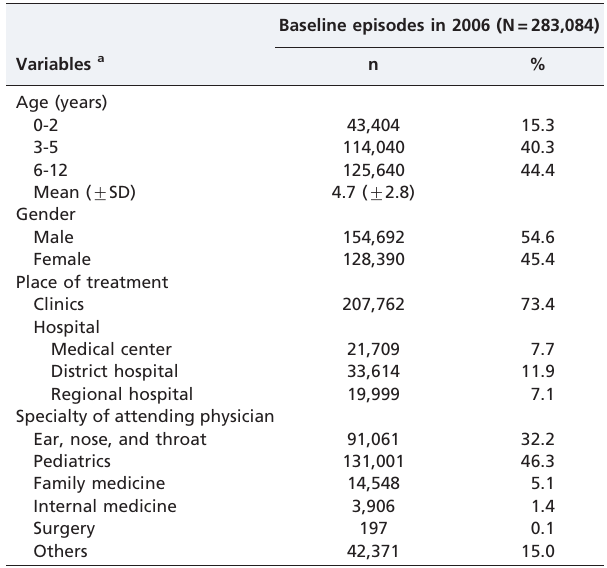
Table 1 - Characteristics of the baseline acute otitis media episodes in